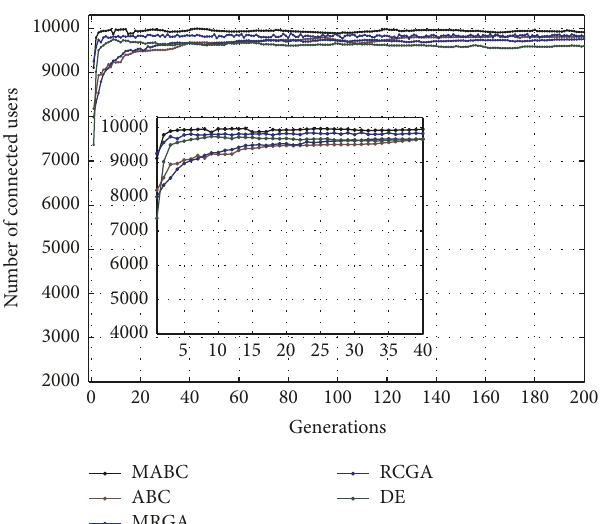
Figure 6: The number of connected users towards a generation.